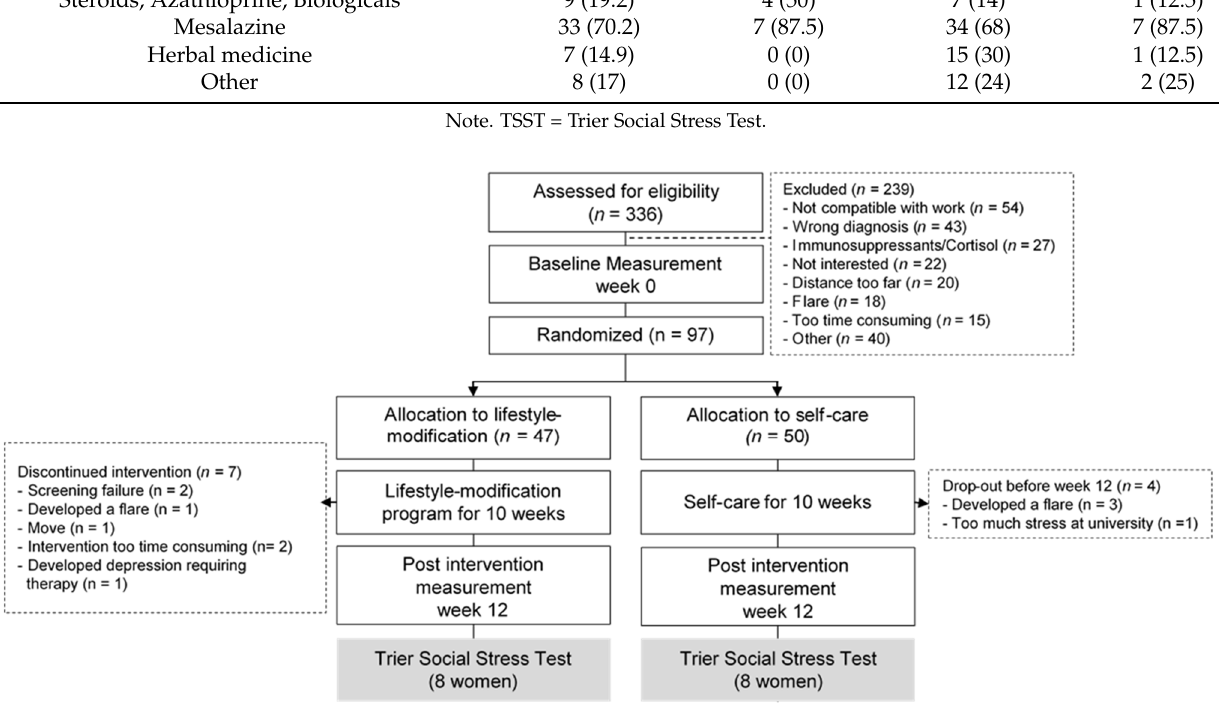
Table 2. Long-term effects of the comprehensive lifestyle-modification program on stress, anxiety, depression and flour- ishing (mean ± standard deviation (range)).